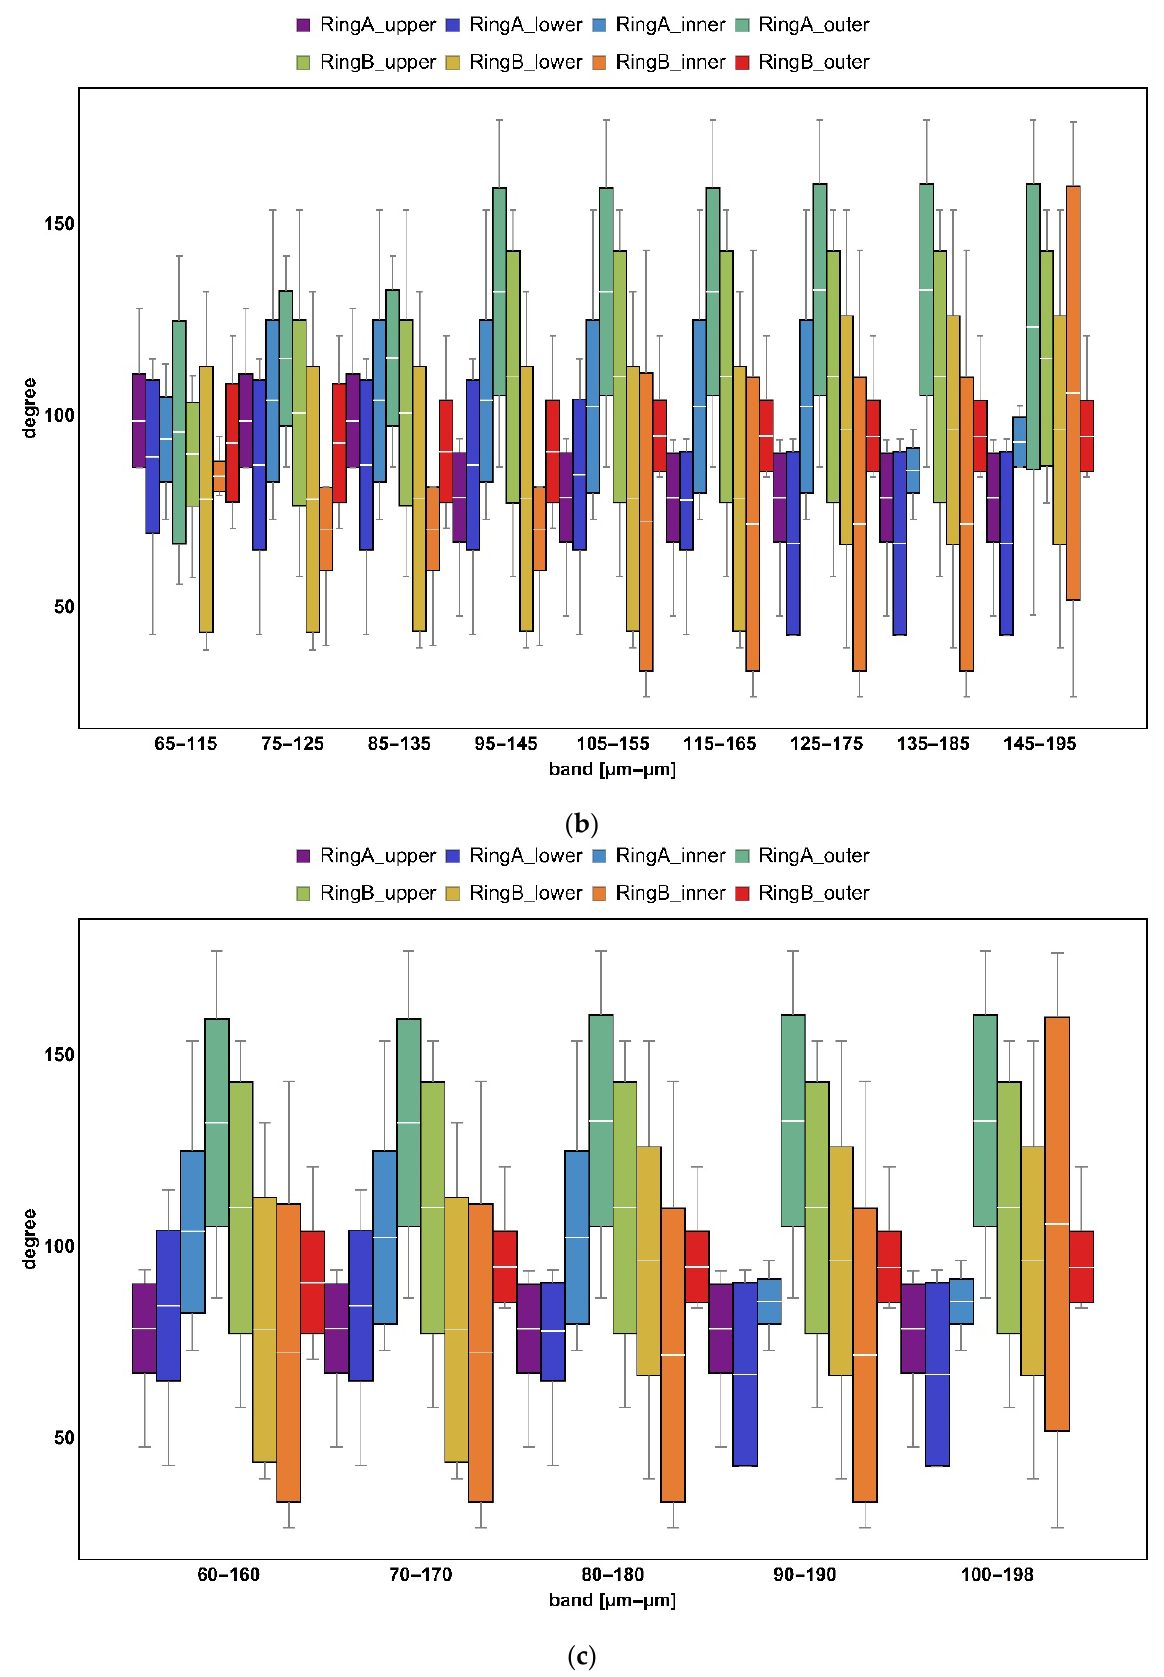
Figure 7. Evolution of texture direction (Std) with scale for three different bandwidths: ( a ) 20, ( b ) 50, and ( c ) 100 µm.